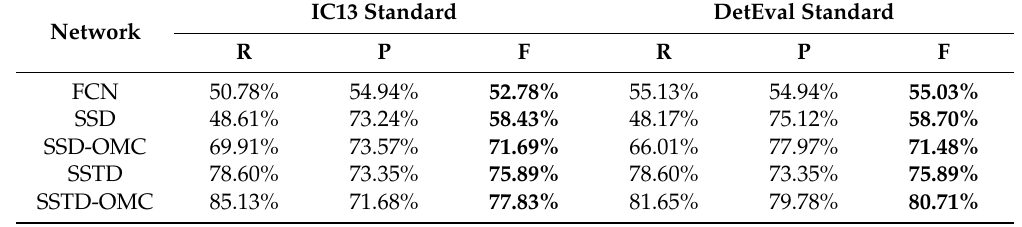
Figure 10. Some detection results and their ground truth from the ICDAR2013 dataset. Table 5. Improved algorithm compared with original algorithm (on SVT).